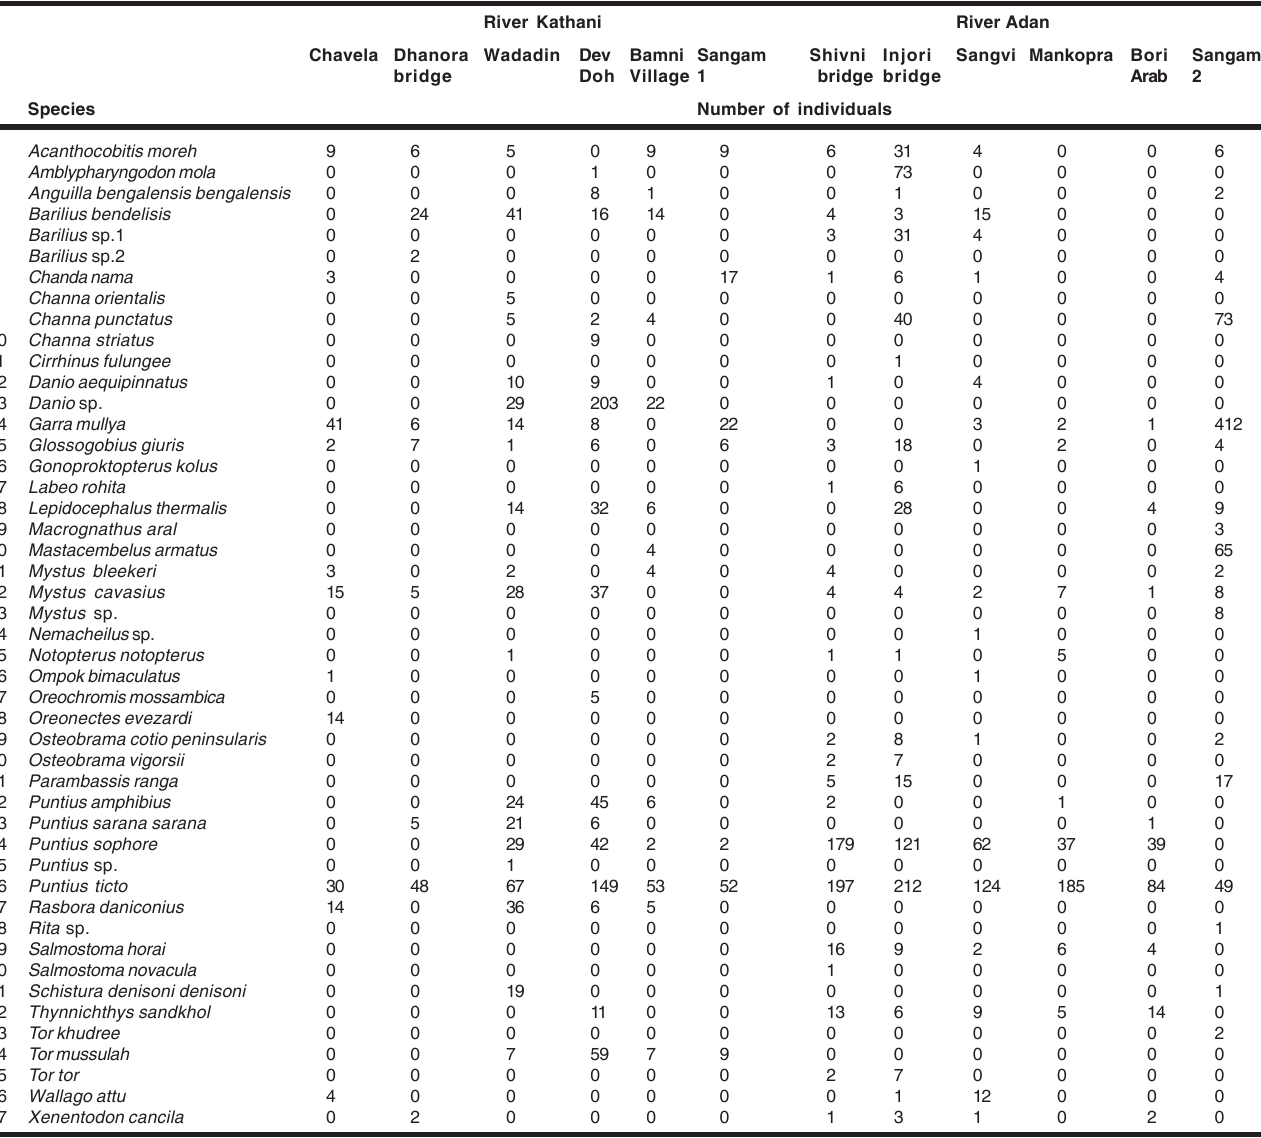
Table 2. Species found at each sampling